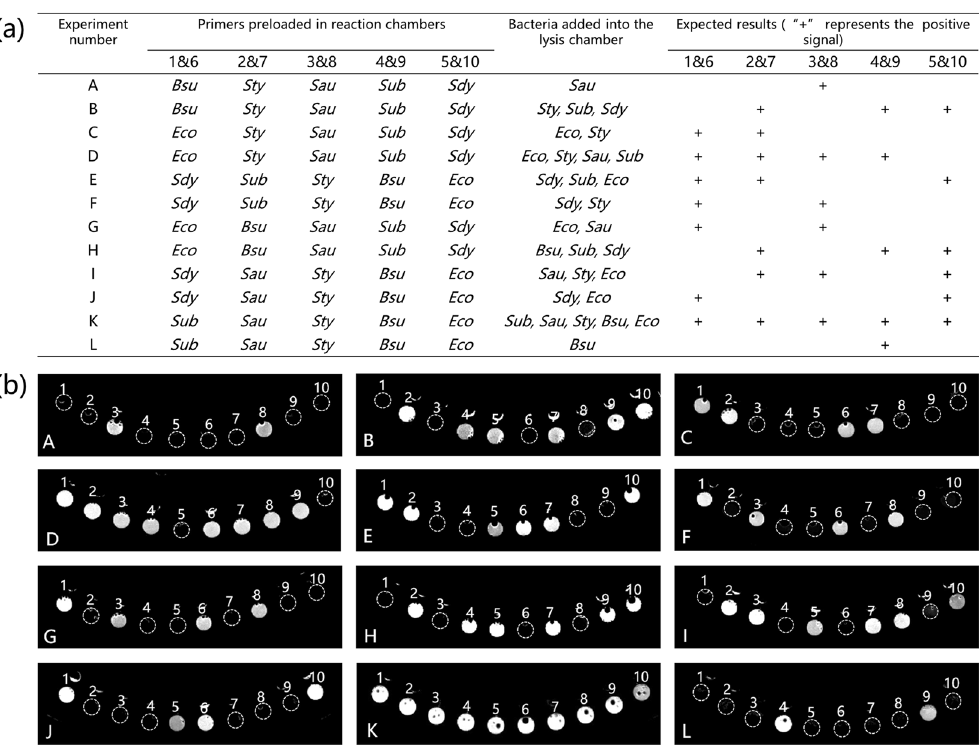
Figure 6. Flexibility and accuracy testing of the chip to detect different combinations of bacteria. ( a ) Design of 12 experiments with different configurations of preloaded primers and different combinations of bacteria. The expected results are also illustrated in the graph. ( b ) Results of each experiment. All reaction chambers were numbered from 1 to 10, and the dashed lines mark the positions of reaction wells with no